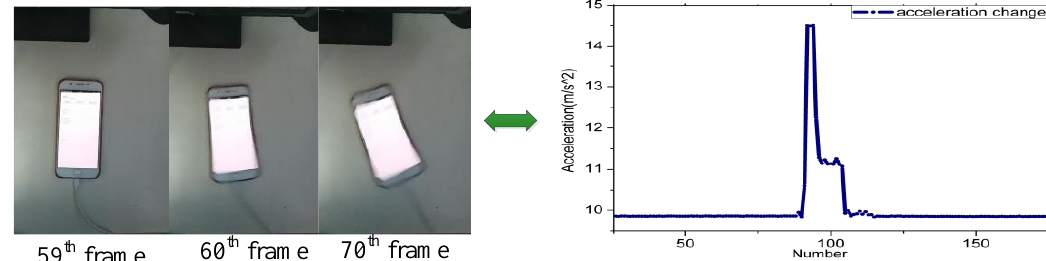
Figure 3 . Time relationship between the device and video surveillance